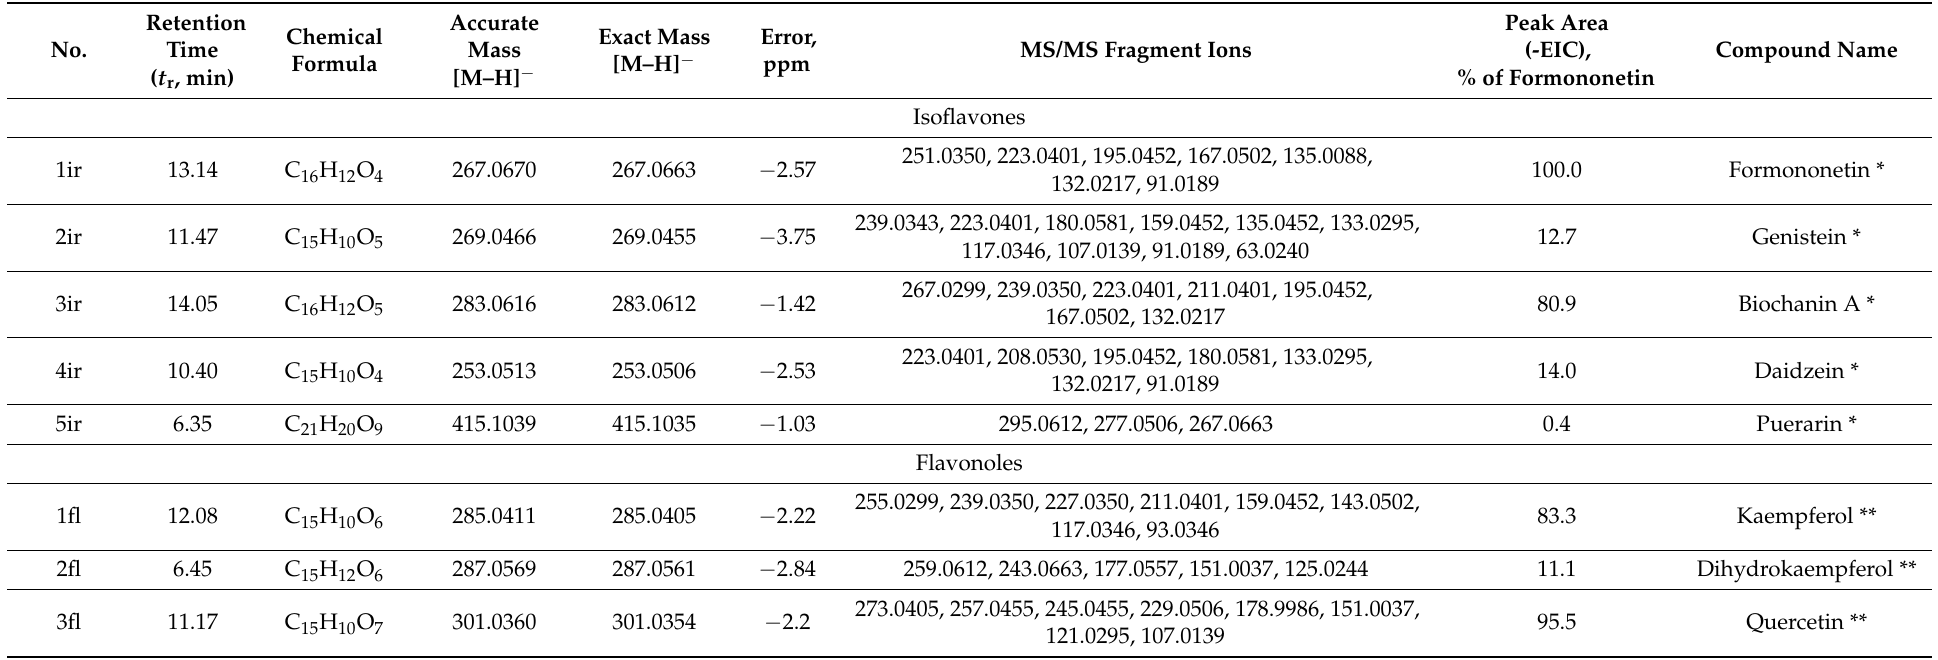
Table 3. Major flavonoids identified in the extract of red clover using